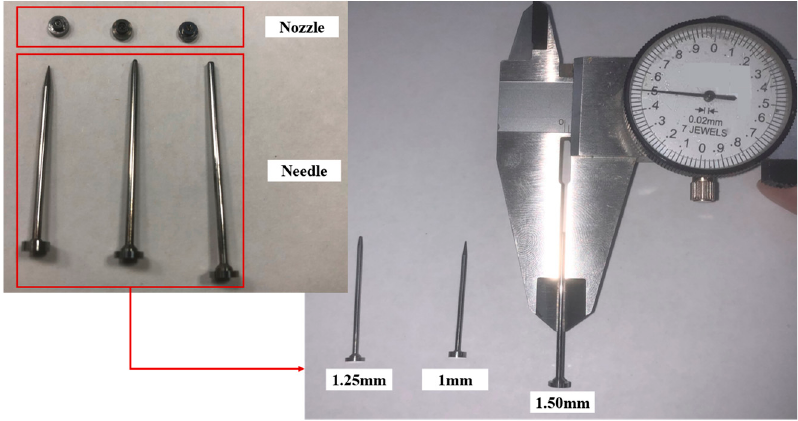
Figure 9. Different sizes of nozzle and needle samples. Table 3. Statistics of the